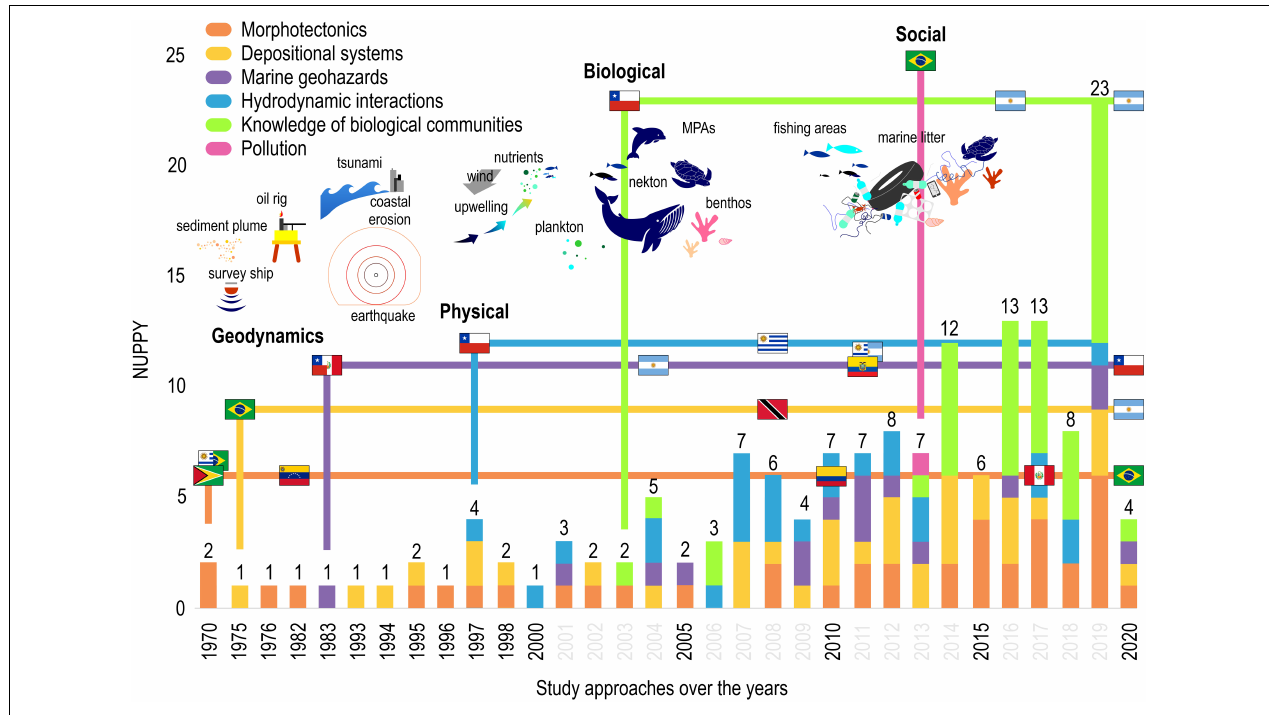
FIGURE 4 | Timeline evolution of submarine canyons studies in South America, highlighting the changes in the specificity of study trends (geodynamics, physical, biological, and social) and their main publication agents to represent the arise point of Number of Publication per Year (NUPPY) among the countries and their first specificities of studies over the